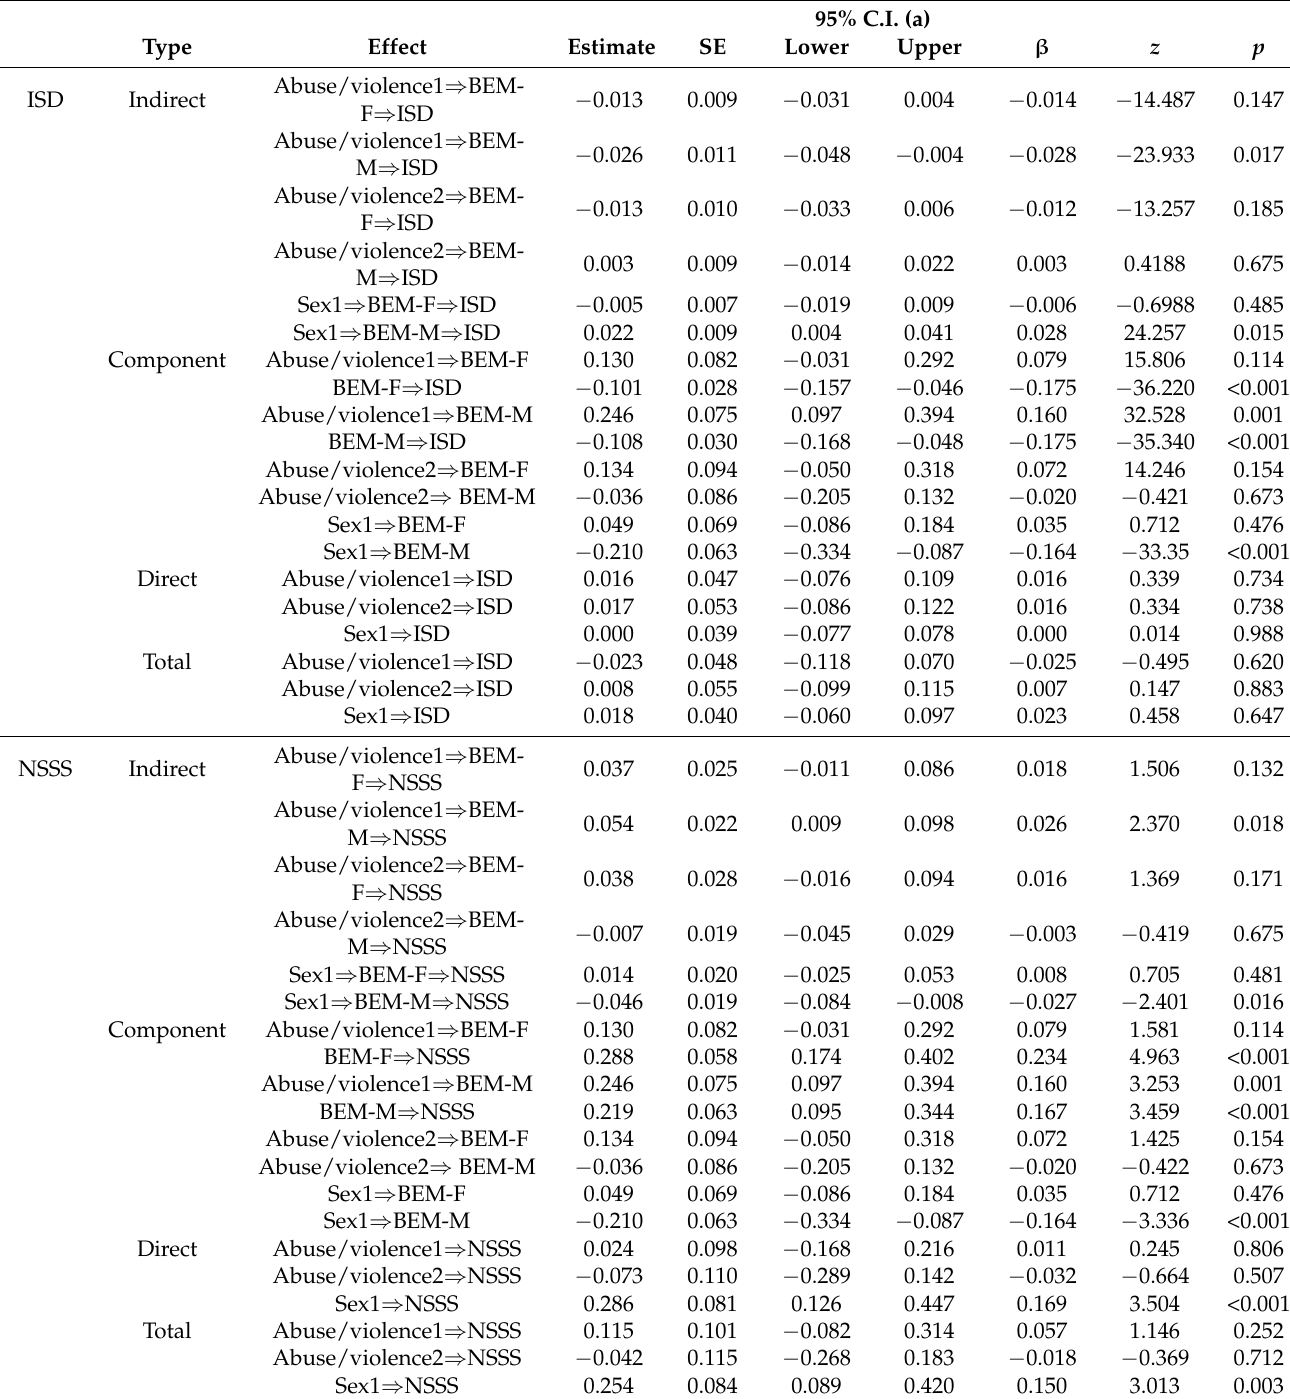
Table 2. Indirect and total effect from mediation analysis for ISD and